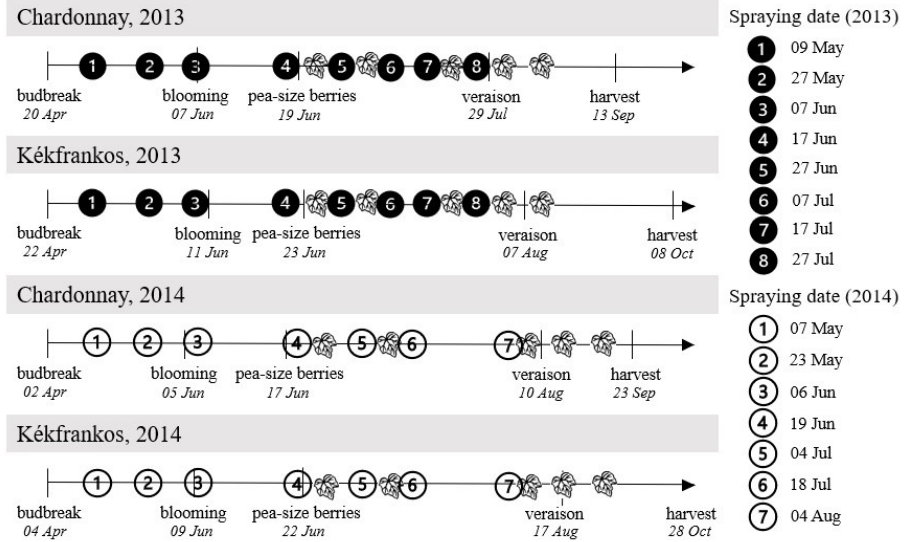
Figure 1. Dates of main phenological stages, harvests, sprayings, and gas exchange measurements (marked with leaf symbols) for both cultivars and years.